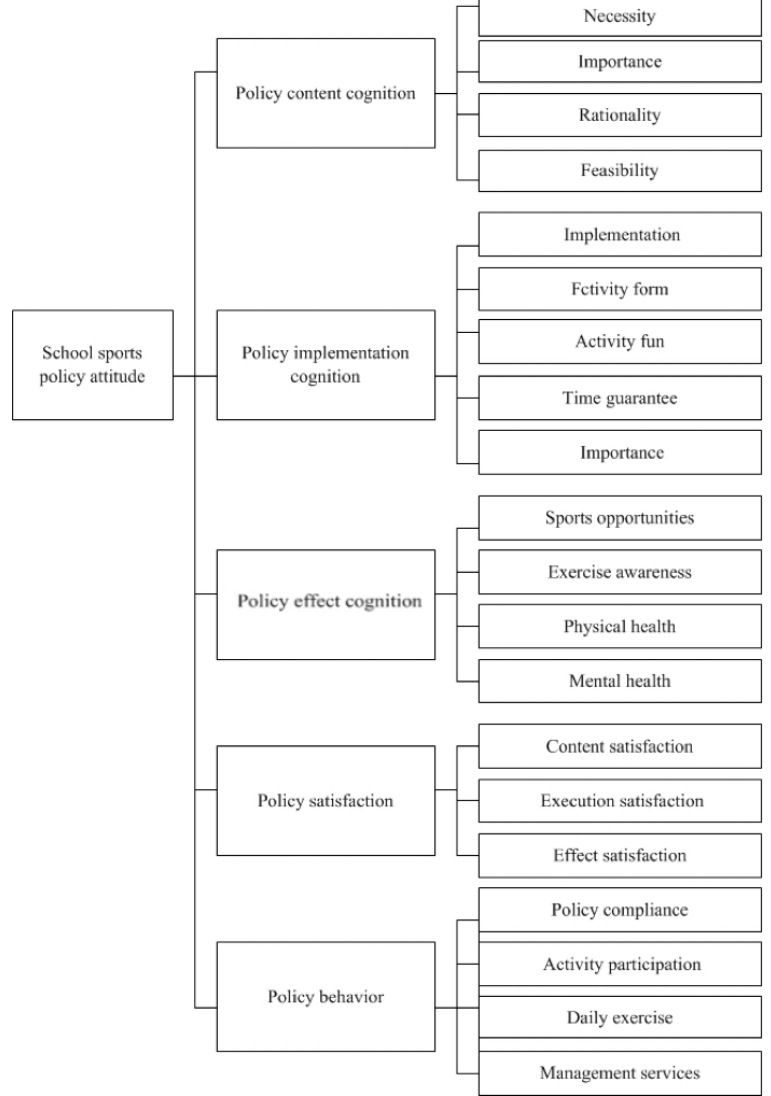
Figure 1. Content framework of school sports policy attitude .